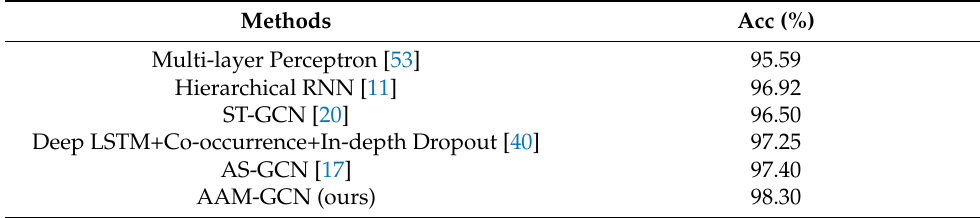
Table 3. Comparison results of various methods on the HDM05 dataset.